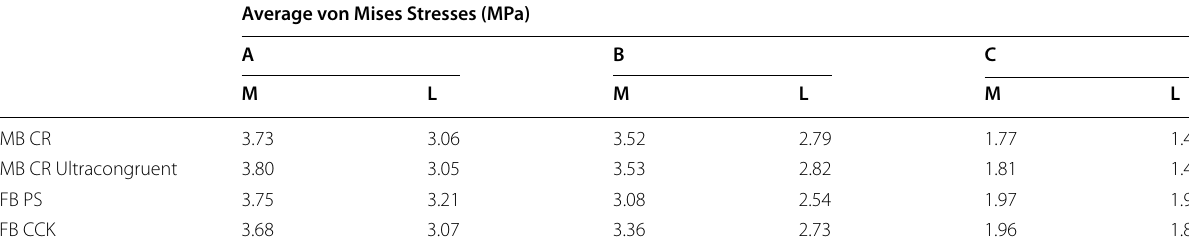
Table 4 Average medial and lateral von Mises stresses (MPa) in the distal region of the cortical tibial bone Average von Mises Stresses